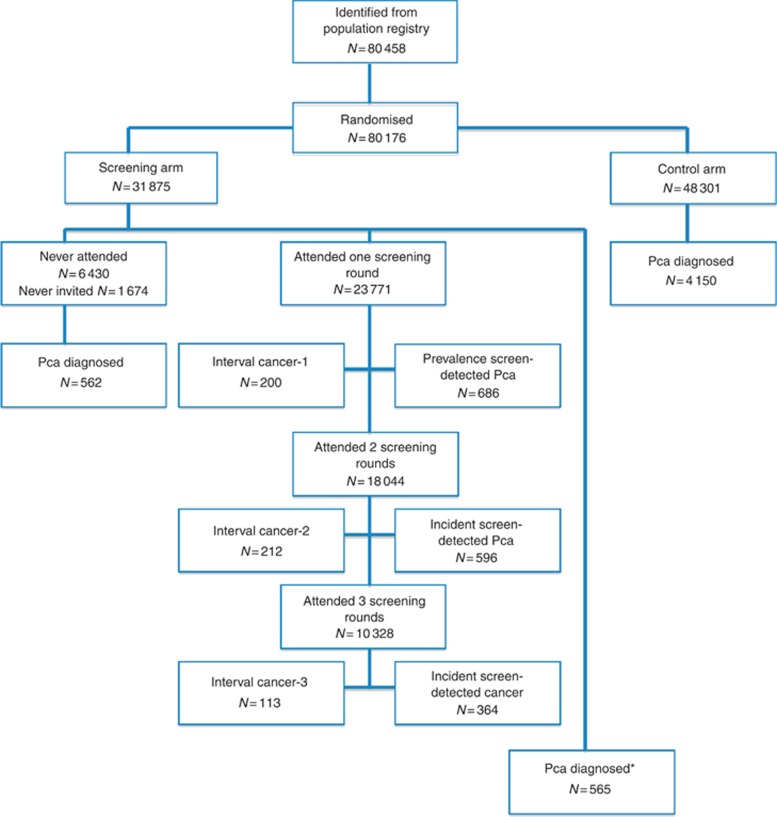
Flow chart of the Finnish Prostate Cancer Screening Trial. *Cancer diagnosed more than
4 years since the last screen; 282 men were excluded from randomisation because of death, or
prostate cancer diagnosis. Pca, prostate cancer.